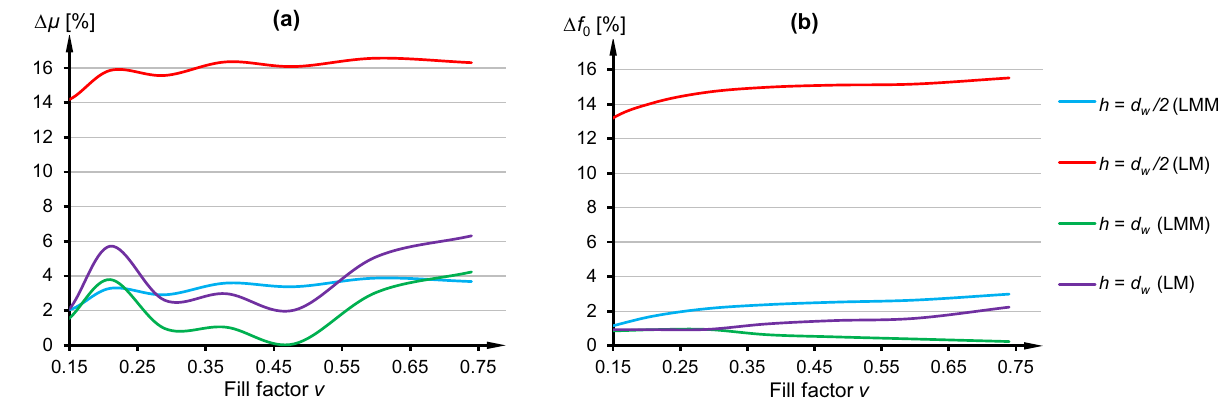
Figure 7. ( a ) Relative difference in extreme values of the effective permeability between analytical and numerical model. ( b ) Relative difference in values of the resonant frequencies between analytical and numerical